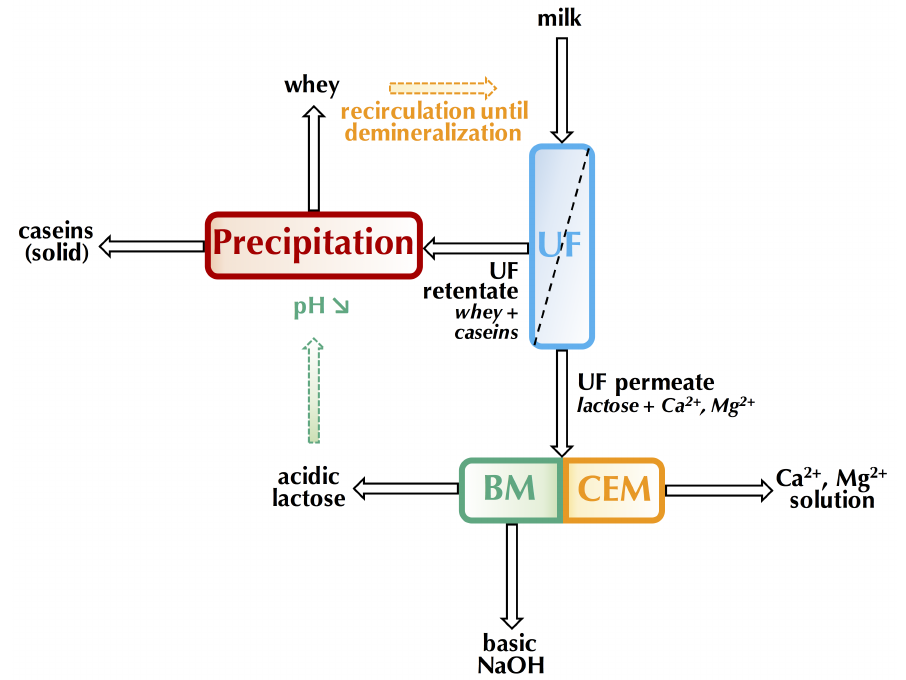
Figure 27. Eco-e ffi cient milk processing by EDBM-UF for casein production (adapted from Mikhaylin et al. [335]). UF: ultrafiltration; BM: bipolar membrane; CEM: cation-exchange